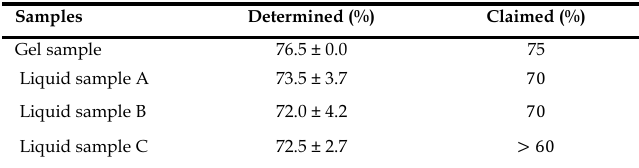
Table 3: Determination of alcohol percentage in commercial